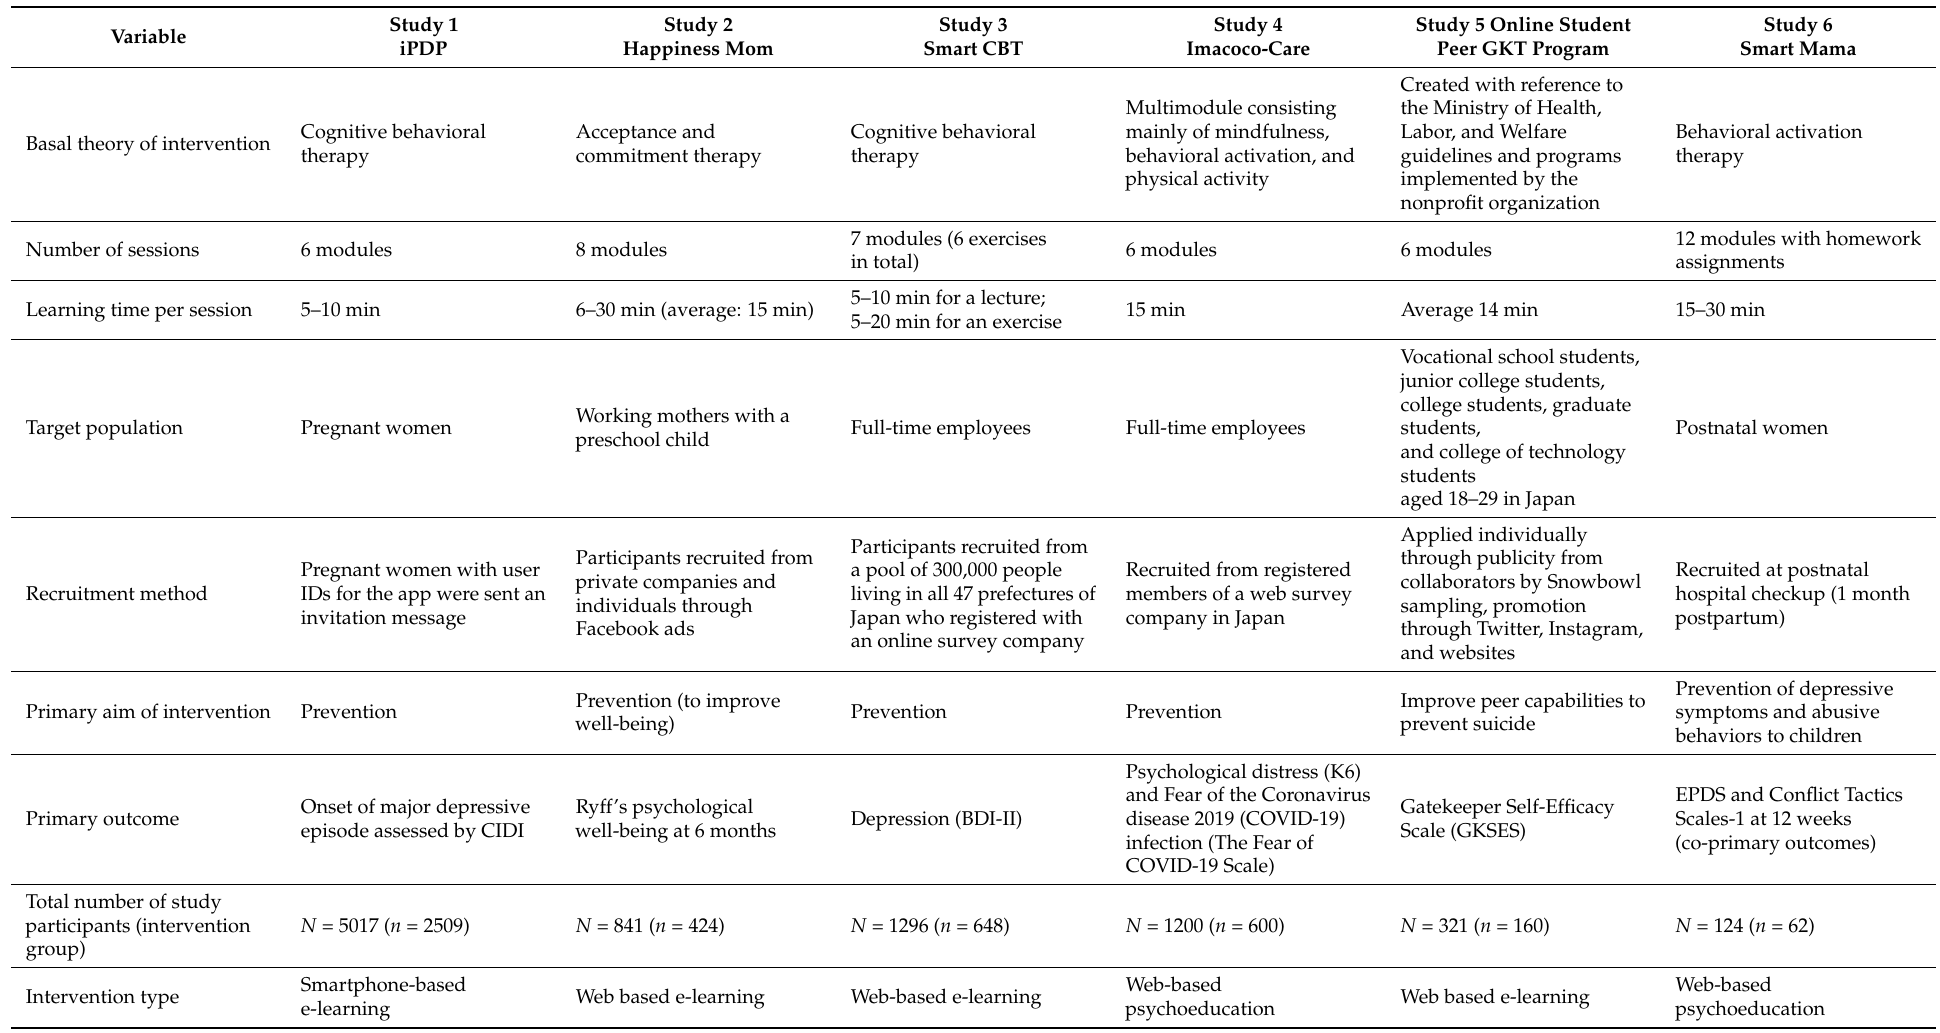
Table 1. Study Characteristics of Six Randomized Controlled